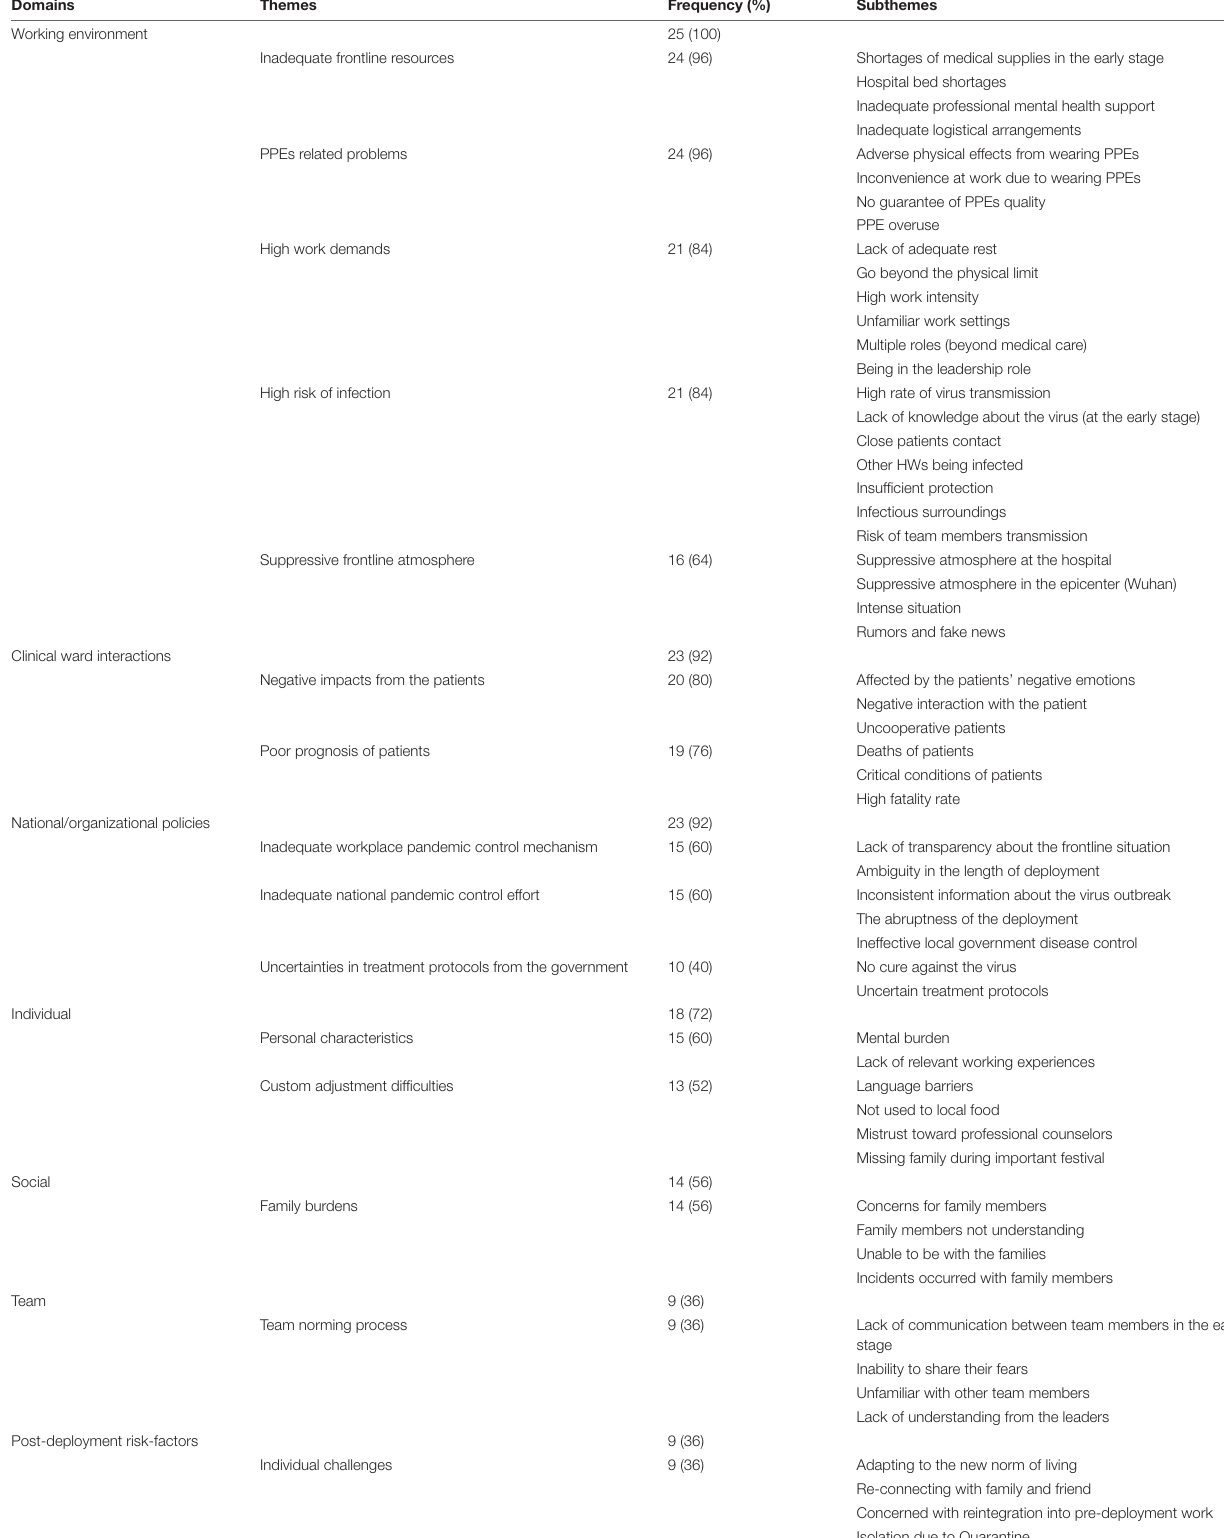
TABLE 3 | List of domains, themes and subthemes of risk factors for the well-being of the 25 interviewees.